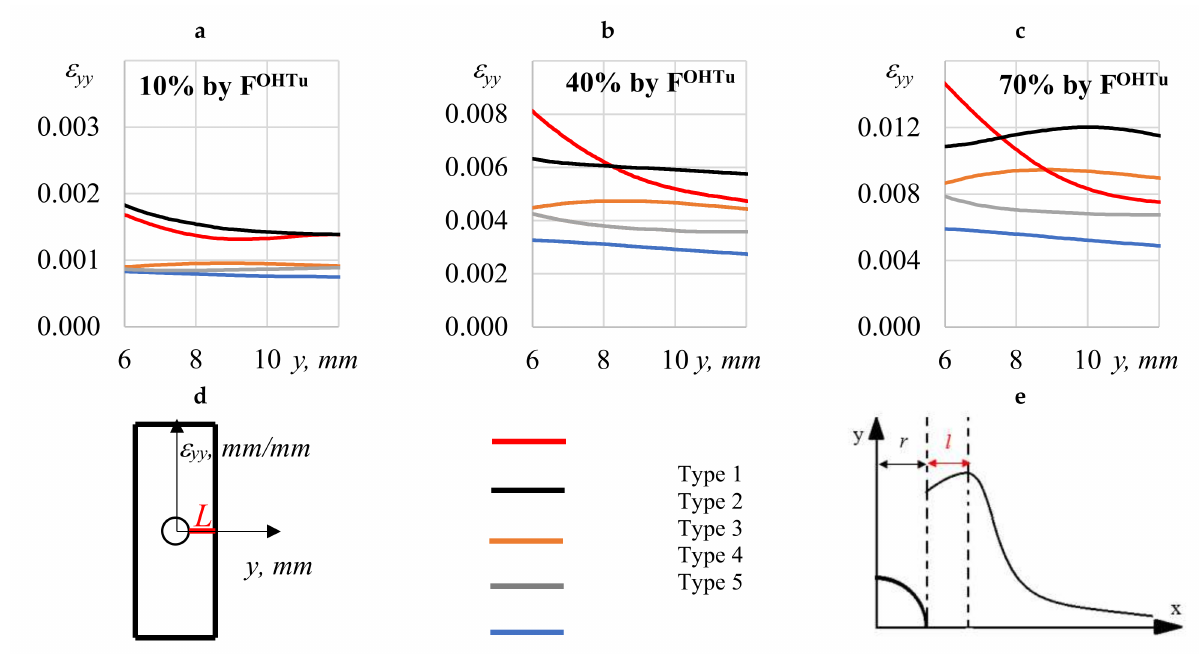
Figure 7. Profiles ( ε yy ) on the sample surface at specific stress levels of 10% ( a ), 40% ( b ), and 70% ( c ) of the ultimate stress F OHTu . Profiles ( ε yy ) on the sample surface ( d ). The schematic distribution of the strain ( ε yy ) ( e